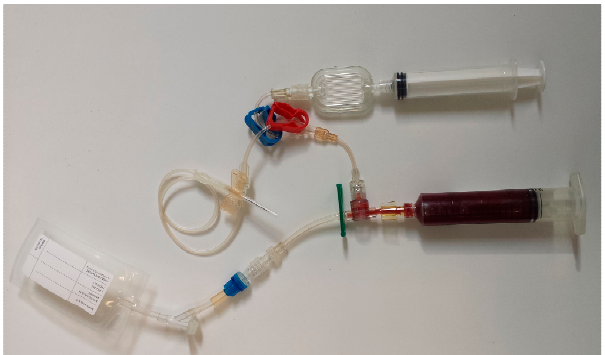
Figure 3. The part of the kit with the butterfly and the anticoagulant port (above) and the part of the kit dedicated to the production of the PRP (below).